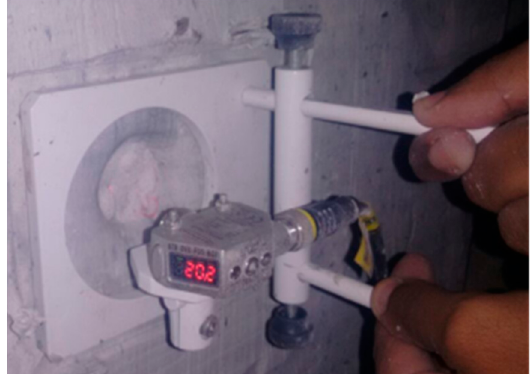
Figure 4. Depth of indentation in the clay witness measured with laser sensor caliper.